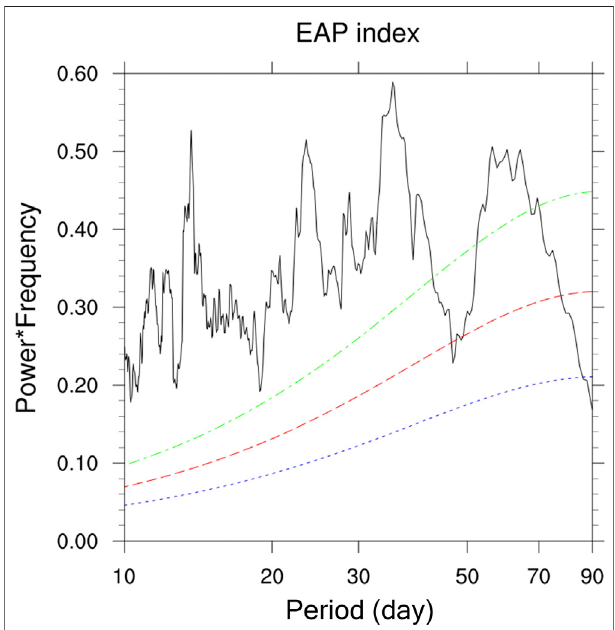
FIGURE 1 | Power spectrum of the EAP index averaged during the 41- years analysis period. The red dashed line is 95% con fi dence level and the green and blue ones are respectively maximum and minimum Markov con fi dence